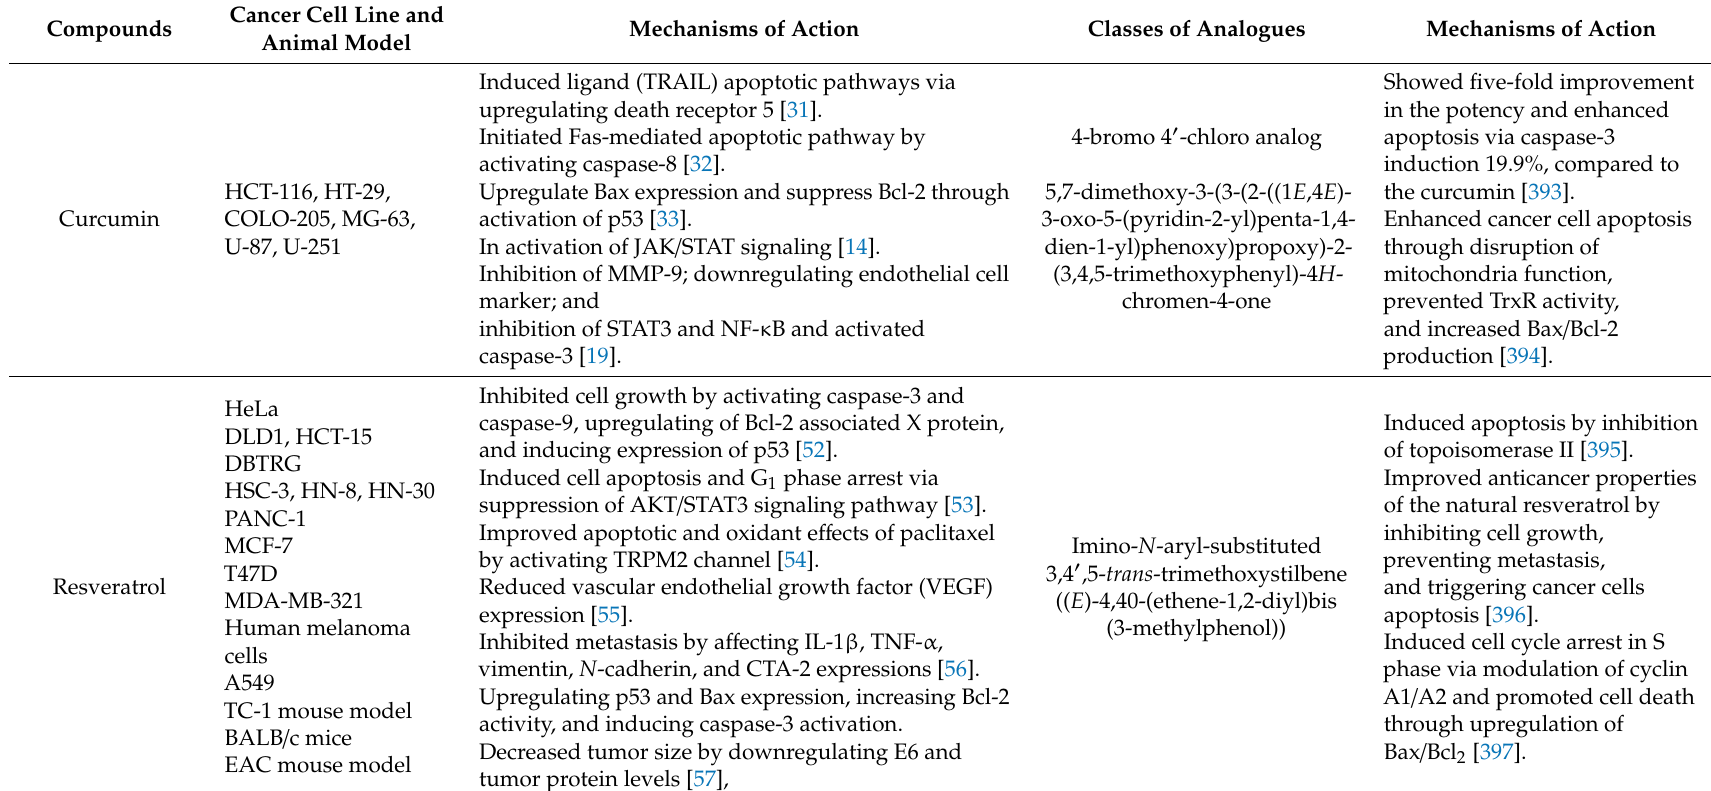
Table 1. Mechanisms of action of natural products and their